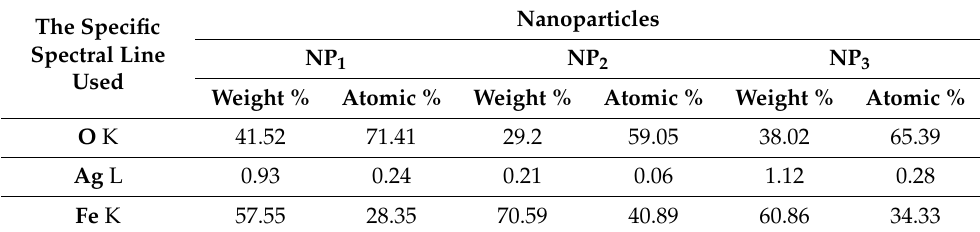
Table 4. EDAX results for the prepared nanoparticles.